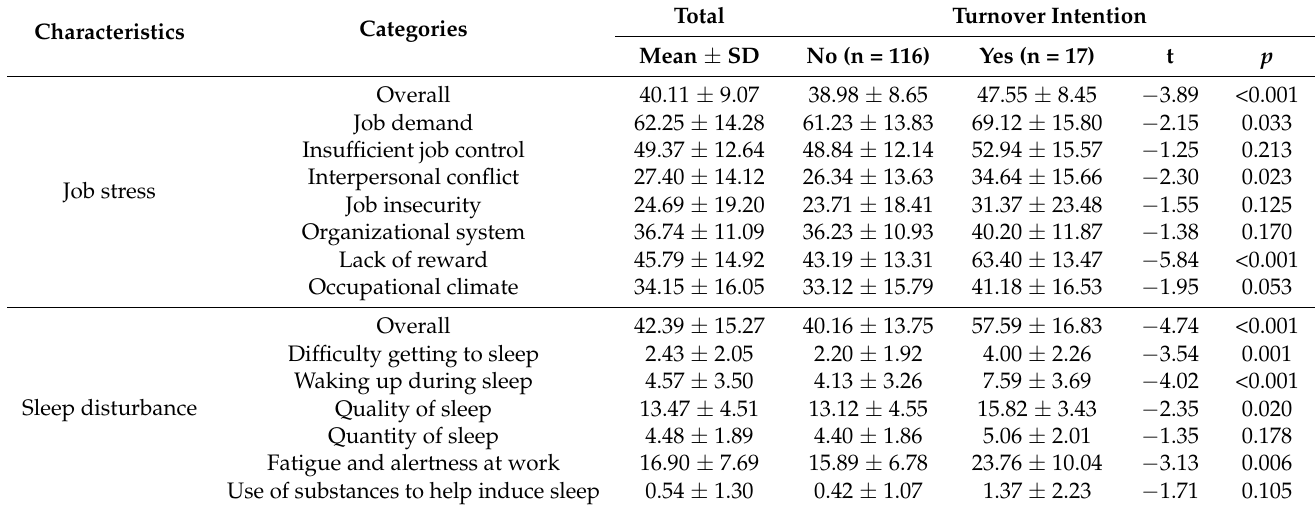
Table 2. Participants’ job stress and sleep disturbance ( N =